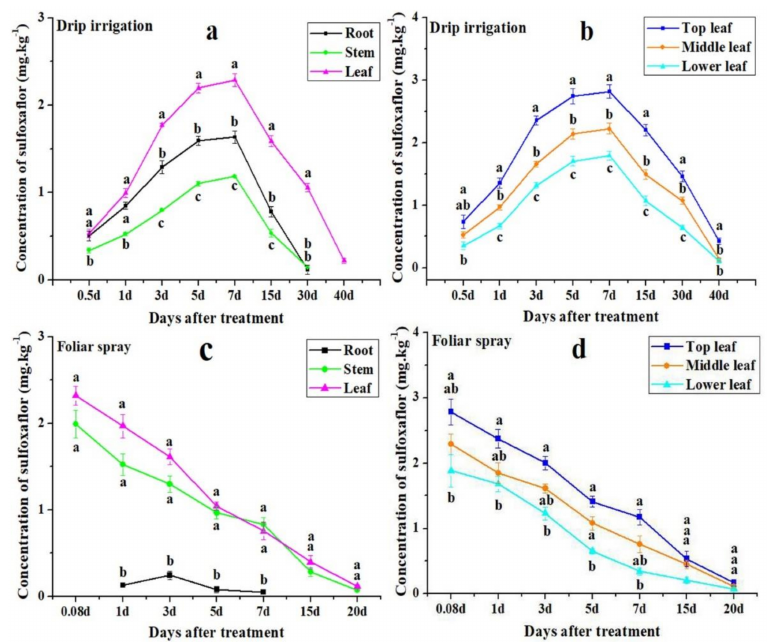
Figure 1. Distribution of sulfoxaflor applied through drip irrigation in roots, stems, and leaves ( a ) and in top, middle, and low leaves ( b ), and via foliar spray in roots, stems, and leaves ( c ) and in top, middle, and low leaves ( d ) in 2016. All data are expressed as mean ± S.E. (n = 3). Values within the same time period labeled with di ff erent letters are significantly di ff erent based on Tukey’s HSD test at P < 0.05. Note: concentrations of sulfoxaflor in leaves ( a , c ) were the average value of top, middle, and lower leaves ( b , d ). The same below.